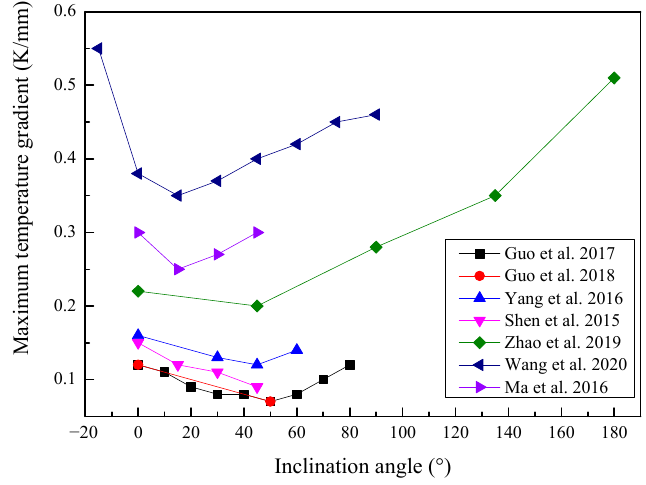
Figure 3. Effect of the isothermal performance on inclination angle of heat pipes.